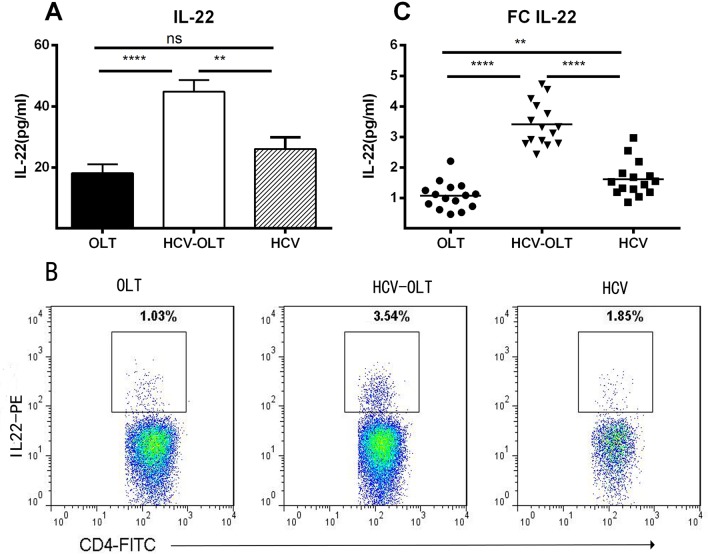
Serum levels of IL-22 and frequencies of IL-22 producing cells in the peripheral blood mononuclear cells in different groups.(A) Serum levels of IL-22 (pg/ml) were tested by ELISA in patients with OLT, HCV-OLT and HCV. (B) Representative figures of IL-22 CD4+ staining in different groups. (C) The frequencies of IL-22 (pg/ml) in HCV-OLT patients were significantly higher than that in normal controls OLT and HCV patients. IL-22 also increased significantly in HCV than that in OLT. *P < 0.05, **P < 0.01, ***P < 0.001, **** P < 0.0001, ns p>0.05. Hepatitis C Virus infection (HCV), Hepatitis C Virus recurrence after orthotopic liver transplantation (HCV-OLT), Control post-transplant cases (OLT).